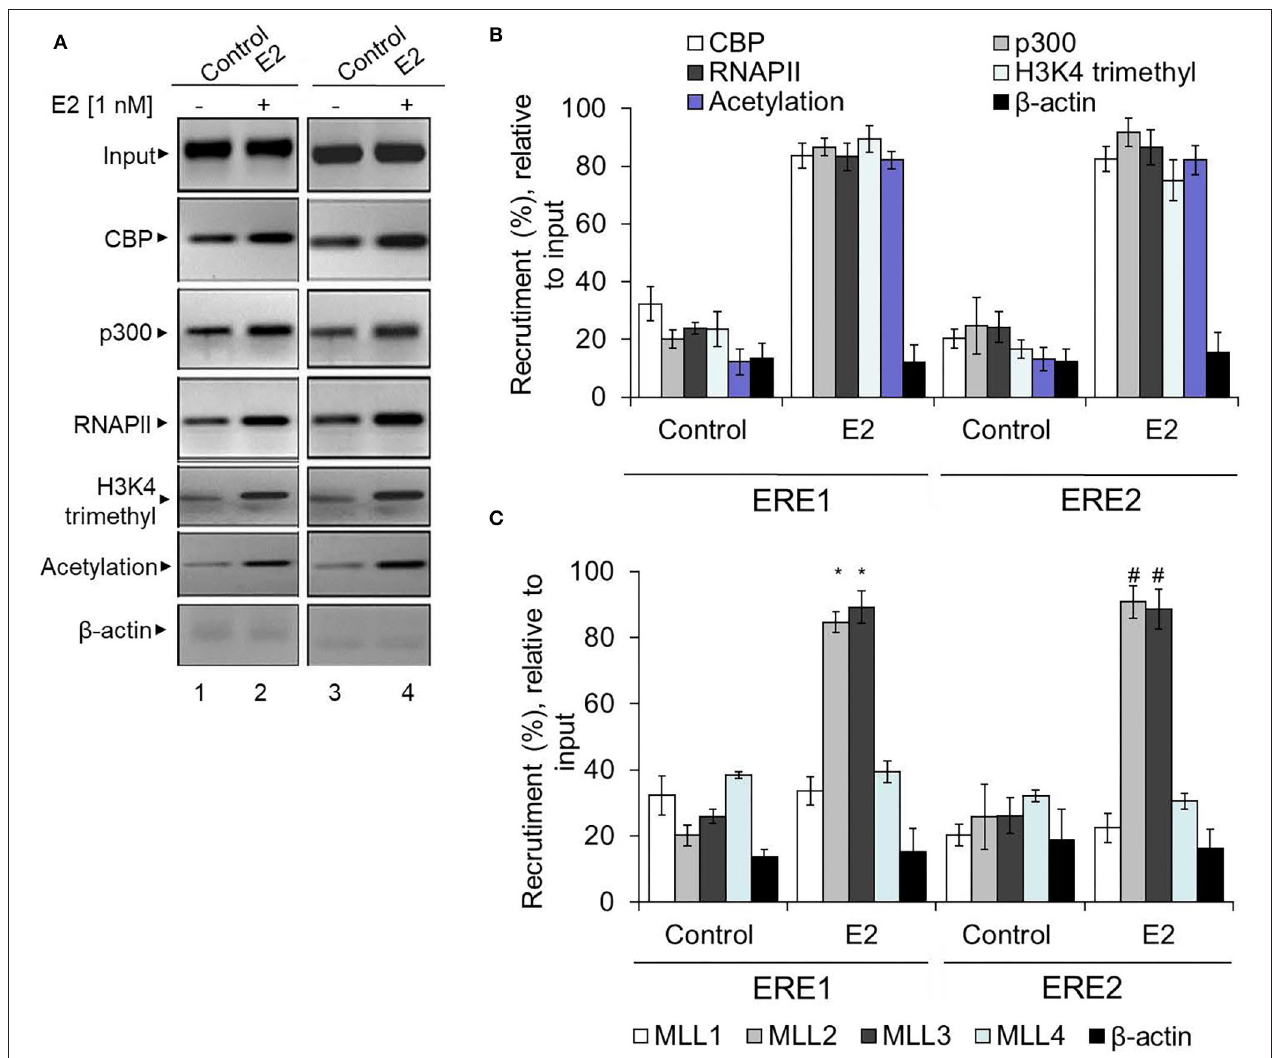
FIGURE 7 | Enrichment of ER co-regulators at the HOXA5 promoter EREs. E2-treated (1nM, 6h) MCF7 cells were analyzed by ChIP assay using different antibodies. The ChIP DNA was analyzed by PCR using HOXA5 promoter primers (ERE1 and ERE2 regions). An agarose gel analysis showing the recruitment of selected factors on the ERE1 and ERE2 regions of the HOXA5 promoter is shown in (A) . qPCR analysis of the ChIP DNA samples showing the enrichment (relative to input) of CBP, p300, MLL1, MLL2, MLL3, MLL4, H3K4-trimethyl, histone acetylation, RNAP II, and β -actin into the ERE1 and ERE2 regions of the HOXA5 promoter region in the presence of E2 is shown in (B,C) . For (B,C) , bars indicate averages ± standard errors ( n = 3). *denotes p < 0.0001 compared to respective ChIP control for ERE1; # denotes p < 0.0001 compared to respective ChIP control for